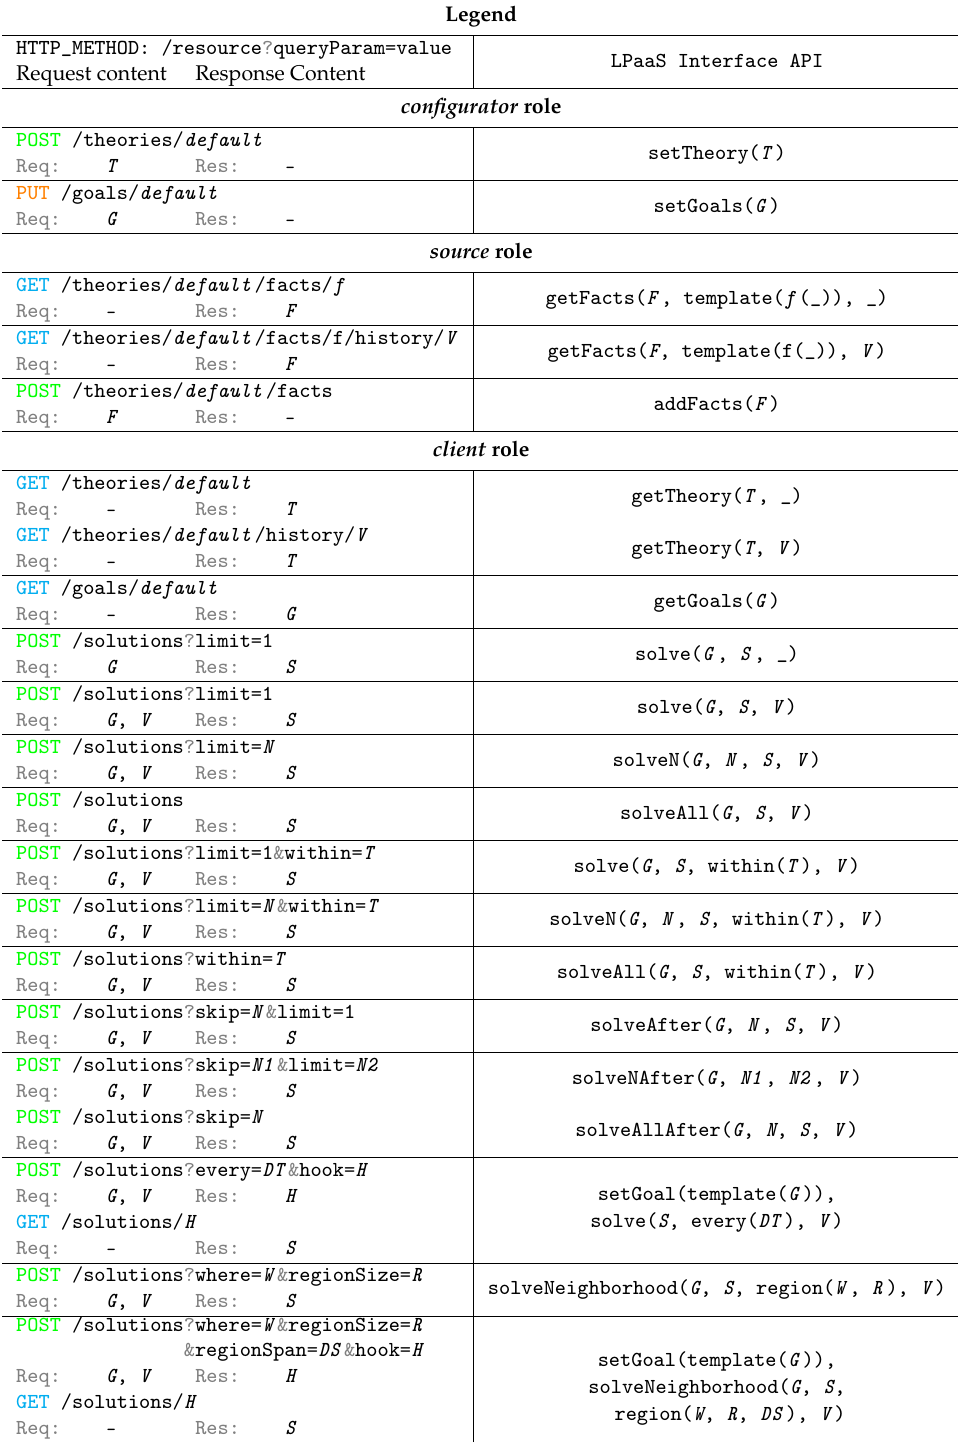
Table 3. The Respresentational State Transfer (REST)ful reification of LPaaS